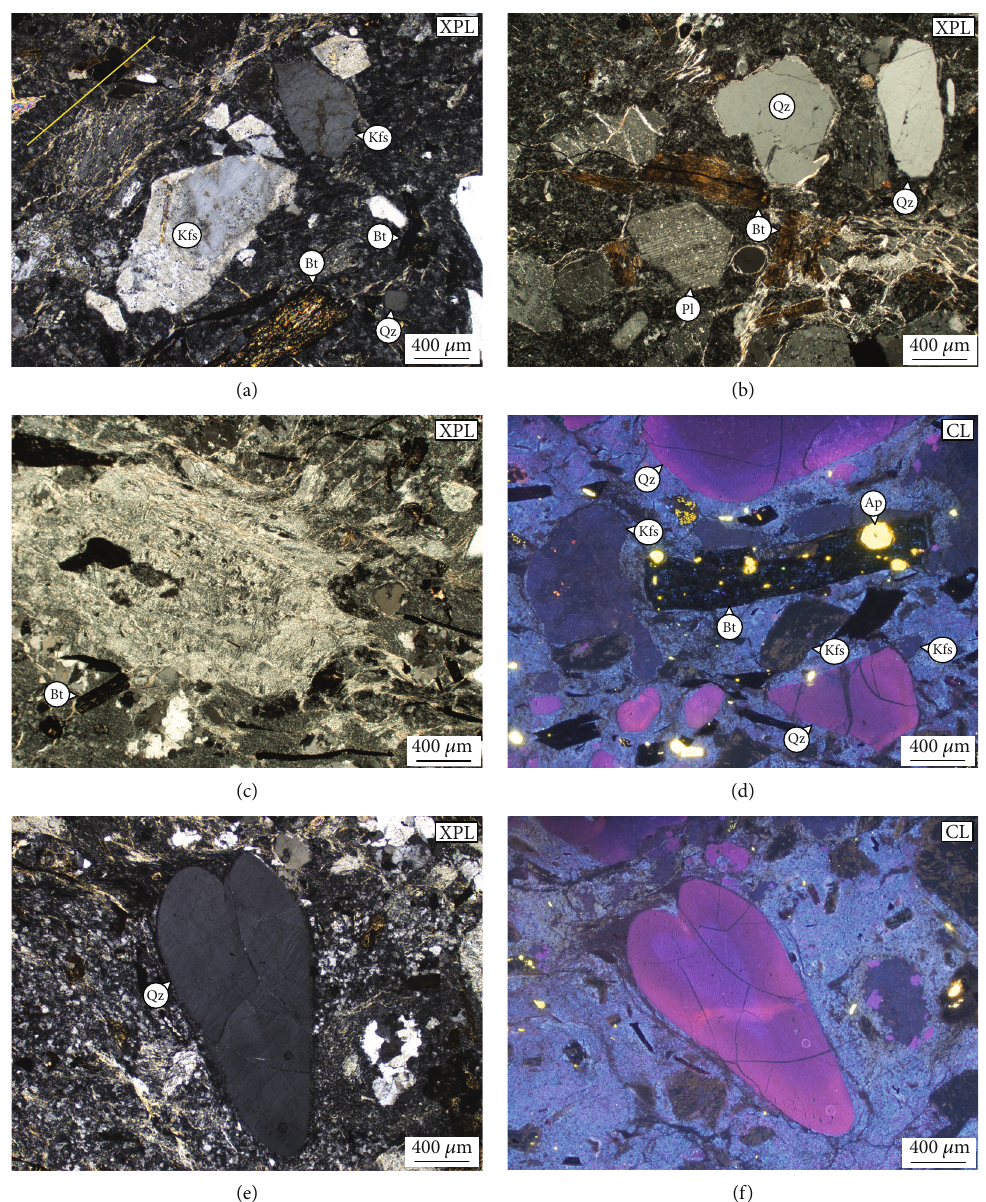
Figure 7: Thin-section photomicrographs of the Permian ignimbrites: crystal and juvenile components ((a, c – f) well Kel – 7 core #8; (b) well Kel – 11 core #5). (a, b) Crystal fragments in the fi ne-grained matrix showing a weakly developed foliation (yellow line in a). Note: the strongly altered ( fl attened and sericitized) pumice shards are oriented, and the feldspar also re fl ects sericitic alterations. (c) Altered juvenile components (sericitized pumice and pumice shards). In the relict pumice clast, the original internal vesicular microstructure has been destroyed. (d) Fractured quartz, altered broken K-feldspar, and apatite+opaque mineral pseudomorphs after biotite in the strongly recrystallized groundmass. Quartz crystals and fragments generally exhibit a reverse zoning pattern with low-intensity blue CL cores overgrown by a relatively high-intensity red CL rim. Small apatite grains show uniform bright yellow luminescence. (e, f) A resorbed and deformed crystal of volcanic quartz displaying variable blue to red (rim and embayments) CL colors. Abbreviations: PPL: plane- polarized light; XPL: cross-polarized light; CL: cathodoluminescence; Ap: apatite; Bt: biotite; Kfs: K-feldspar; Pl: plagioclase; Qz: